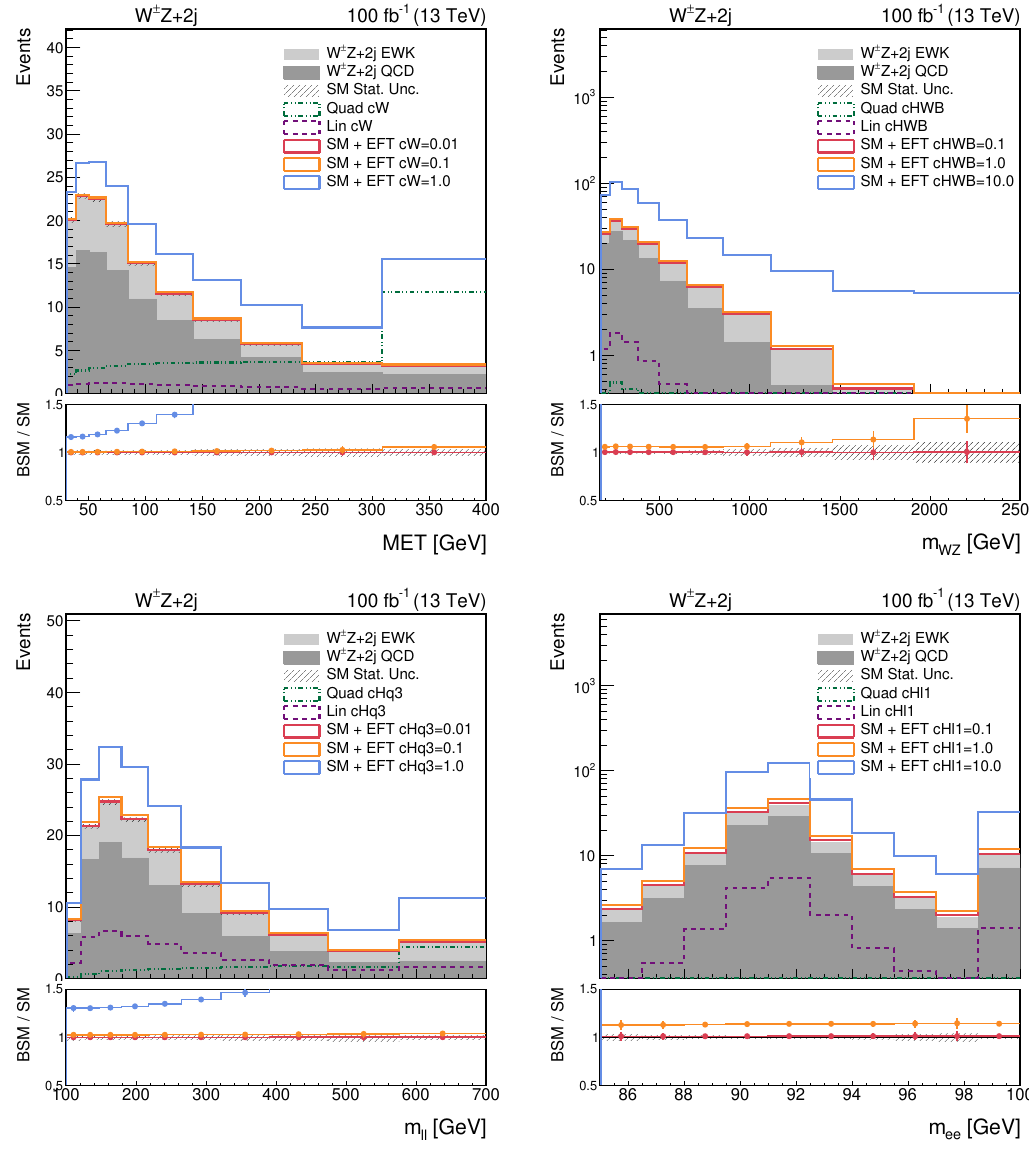
Figure 14 . Comparison of SM (filled histograms) and BSM (lines) expected number of events after the event selection in table 4, for various observables and Wilson coefficients in the WZ+2j-EW and WZ+2j-QCD processes, at an integrated luminosity of 100 fb − 1 . The SM distribution is represented as a stacked histogram, summing EW (light grey) and QCD (dark grey) components. Solid lines show the total prediction for one Wilson coefficient at a time, with c 1 TeV − 2 (blue). The pure interference (quadratic) EFT component, normalized to c is indicated with a purple (green) dashed line. For all distributions, the last bin comprises all the overflow